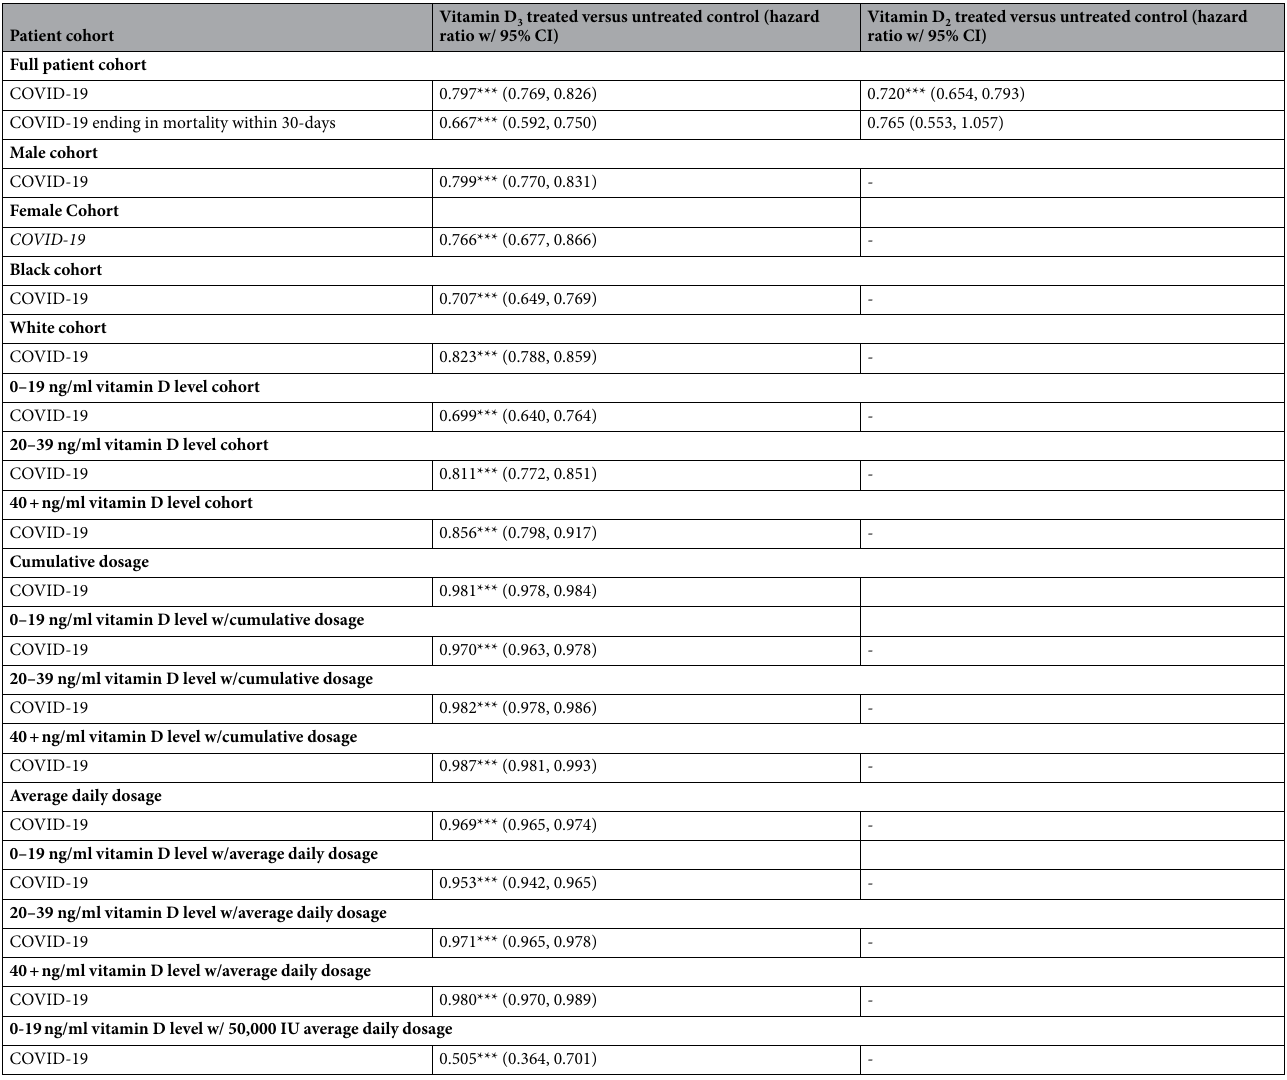
Table 3. Hazard ratio estimates. Parameters expressed, except for cases where cumulative and average dosage are referenced, are for an indicator variable set to 1 if treated and 0 if control. Cumulative dosage is measured as the logarithm of the aggregate dosage during the pandemic period (March 1, 2020–December 31, 2020). Average dosage is measured as the logarithm of the weighted average prescription dosage (weighted by